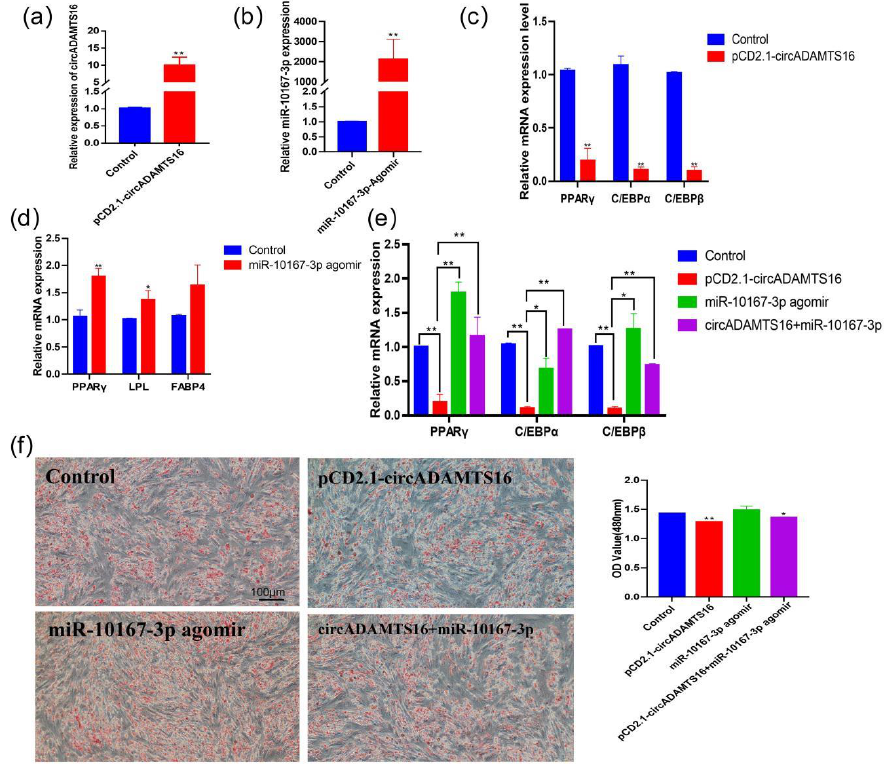
Figure 2. circADAMTS16 targeting miR-10167-3p inhibits differentiation of bovine preadipocytes. ( a ) Expression of circADAMTS16 after transfection of pCD2.1-circADAMTS16. ( b ) Expression of miR-10167-3p after transfection of miR-10167-3p agomir. ( c – e ) Expression levels of PPAR γ , C/EBP α , C/EBP β , LPL , and FABP4 after transfection of circADAMTS16, miR-10167-3p agomir, and circADAMTS16 + miR-10167-3p. ( f ) The negative control, pCD2.1-circADAMTS16, miR-10167-3p agomir, and pCD2.1-circADAMTS16 + miR-10167-3p agomir were transfected into bovine preadipocytes. After eight days of induced differentiation, Oil Red O staining was performed, and the histogram of Oil Red O staining was quantitatively drawn by spectrophotometry. Scale bar indicates 100 µ m * p < 0.05, ** p <